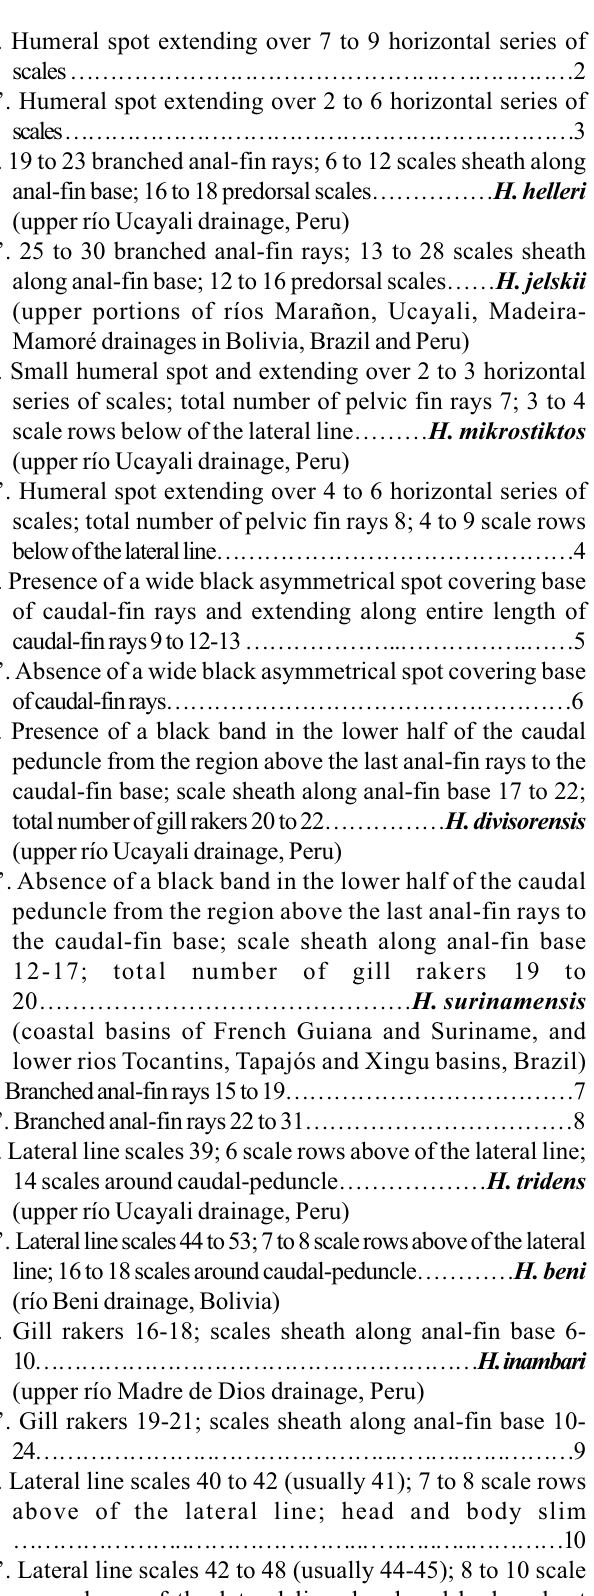
7. Lateral line scales 39; 6 scale rows above of the lateral line; (upper río Ucayali drainage, Peru) 7’. Lateral line scales 44 to 53; 7 to 8 scale rows above of the lateral line; 16 to 18 scales around caudal-peduncle………… H. beni (río Beni drainage, Bolivia) 8. Gill rakers 16-18; scales sheath along anal-fin base 6- (upper río Madre de Dios drainage, Peru) 8’. Gill rakers 19-21; scales sheath along anal-fin base 10- 24…………………. .…………………. .… . .…. .…. .………9 9. Lateral line scales 40 to 42 (usually 41); 7 to 8 scale rows above of the lateral line; head and body slim …………………. .…………………. .… . .…. .…. .…………10 9’. Lateral line scales 42 to 48 (usually 44-45); 8 to 10 scale rows above of the lateral line; head and body robust …………………. .…………………. .… . .…. .….